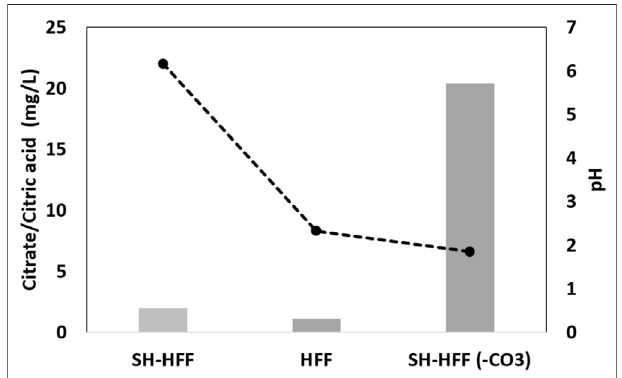
FIGURE 8 | The change in pH due to carbonate dissolution plotted with